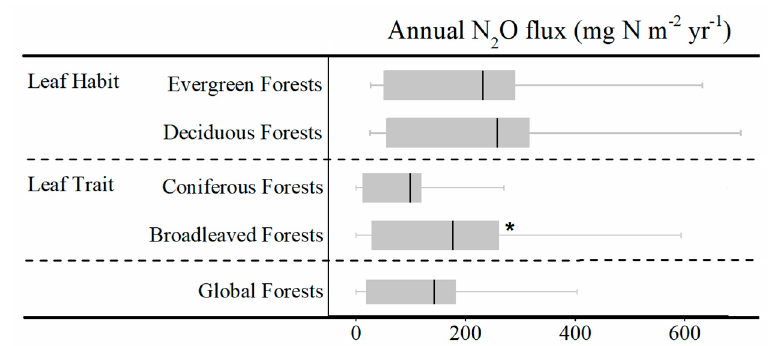
Figure 2. Comparisons of mean annual nitrous oxide (N 2 O) fluxes of different leaf habits (LH), leaf traits (LT), and total global forests. Black lines show the mean of the N 2 O fluxes. *Represents statistically significant differences ( p < 0.05) among different groups.